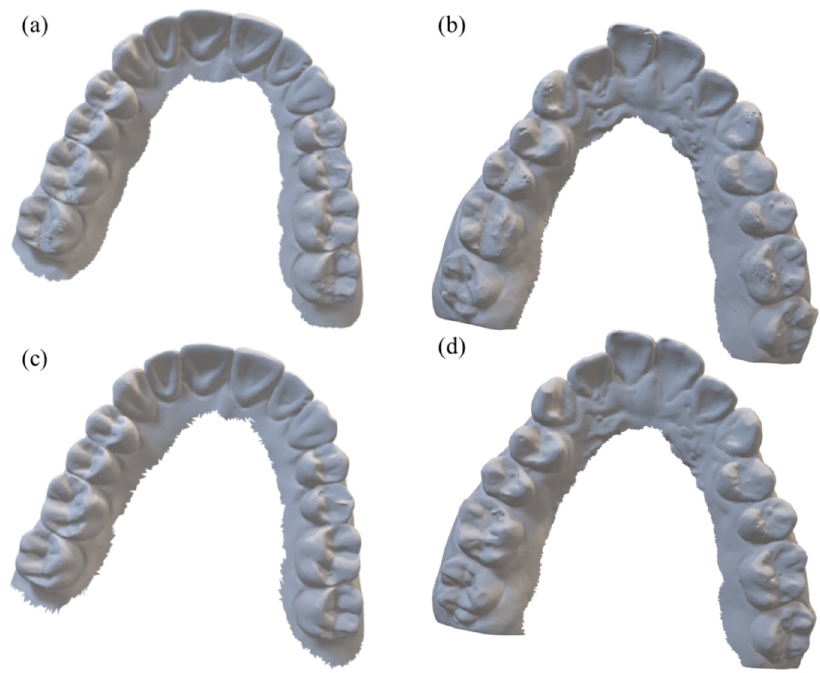
Figure 7. The 3D models computed from the CT images of ( a , c ) Model 1 and ( b , d ) Model 2 taken at the cone-beam angle of 10 degrees. The top and bottom rows have been obtained from the images reconstructed by FDK and CW-FDK, respectively.